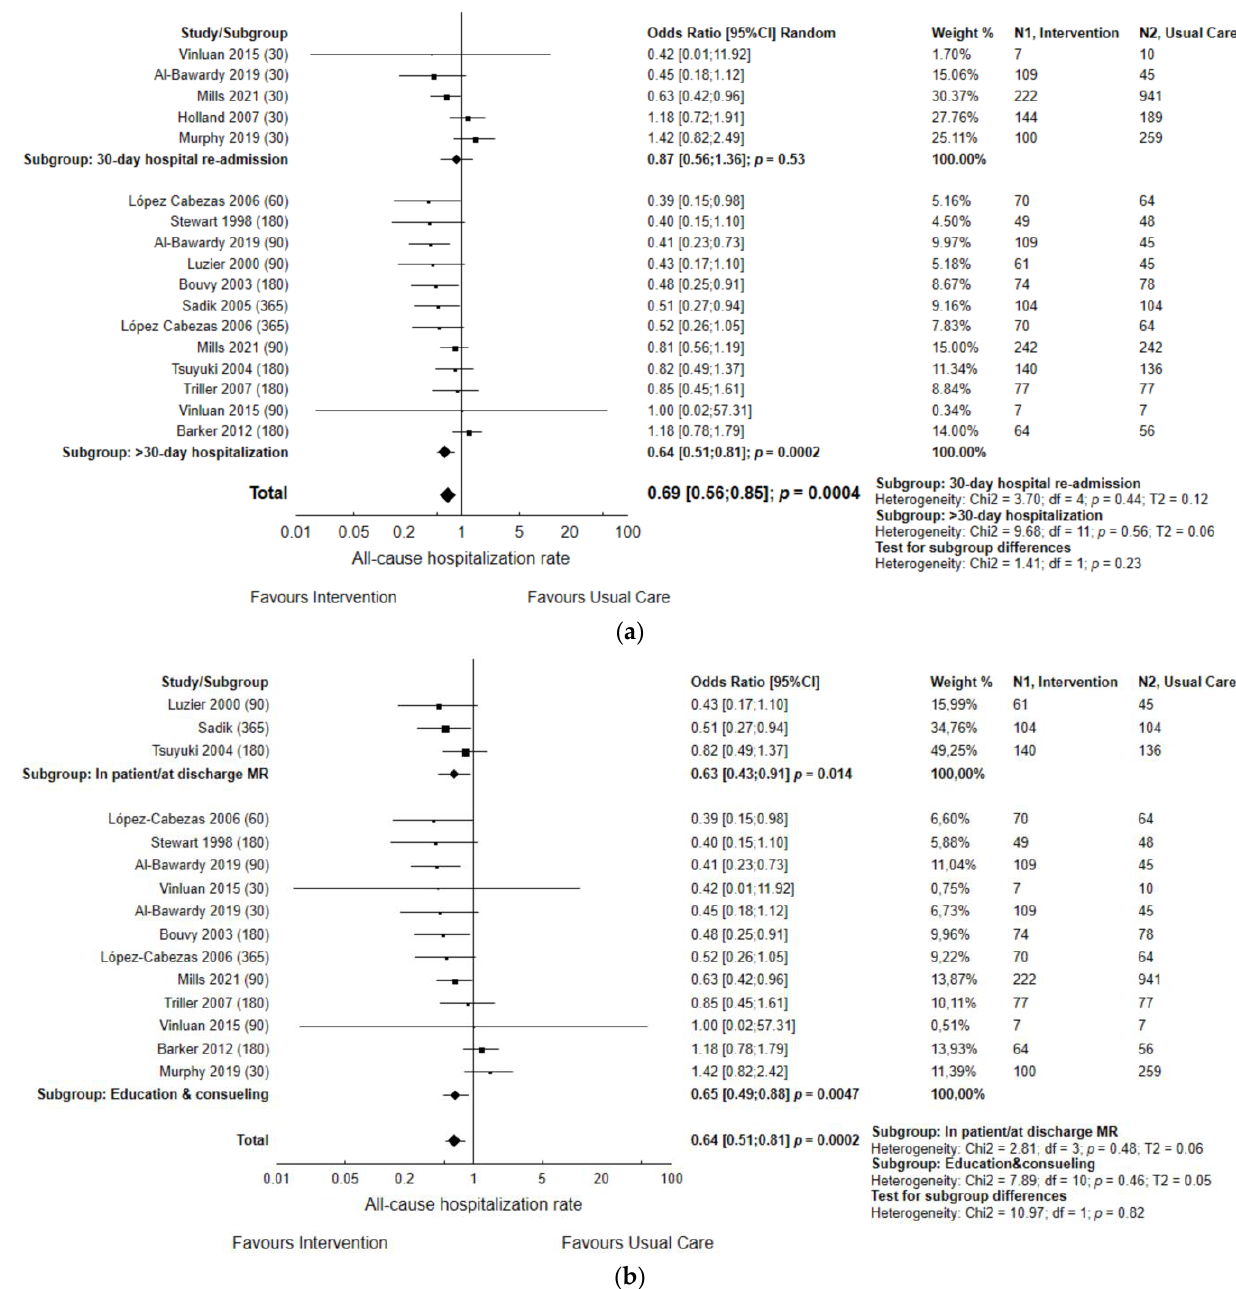
Figure 3 . Forest plot comparing intervention vs. usual care for dichotomous data concerning hospitalization rate (odds ratio, OR) in studies where 100% of patients were hospitalized from heart failure. ( a )—all cause hospitalization, including 30-day re-admission, according to the number of days before the next admission to hospital. Pharmacist-led interventions caused a significant reduction in the risk of hospitalization within >30 days after discharge. ( b )—all cause hospitalization according to type of pharmacist-led intervention. The first sub-group (in-patient/at discharge MR) received services that were focused on in-patient medication reviews and/or reconciliation at discharge, while the second group was prepared for the transition from hospital to home, mainly by counselling and education. Both types of intervention significantly reduced the risk of hospital admission. Days of follow-up are shown in brackets [3,18,19,22,26,33,34,37,40,43–45,47]. In 11 studies, the efficacy of interventions taken by multidisciplinary teams was as- sessed in relation to all-cause hospitalization rates (30-day, or >30 days after discharge). The additional analysis aimed to compare the effects of care with clinical pharmacists as a part of